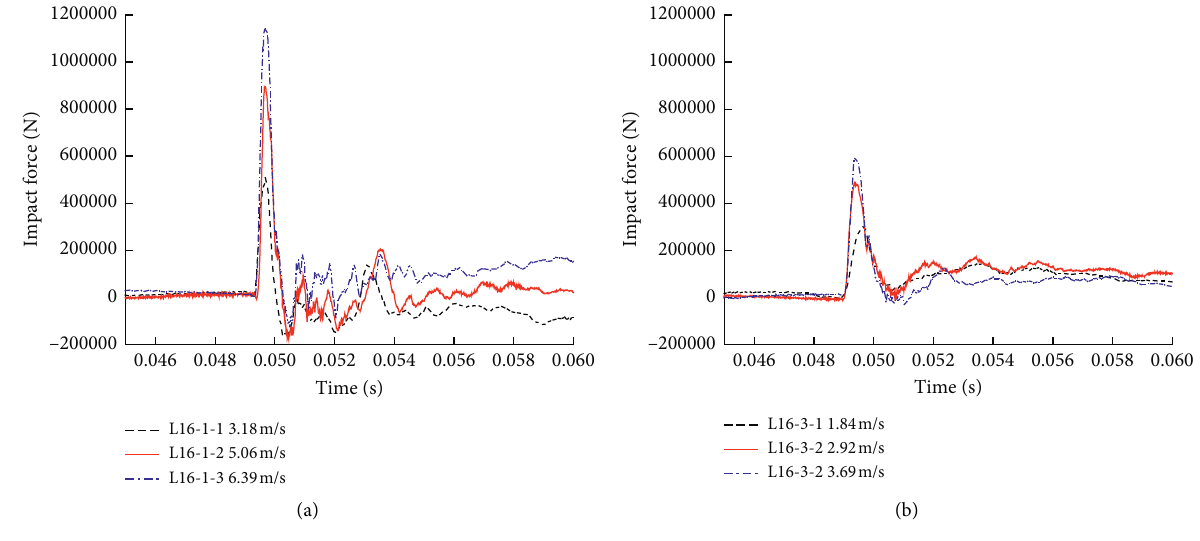
Figure 6: Time-history curves for the cumulative impact force: (a) L16-1; (b)